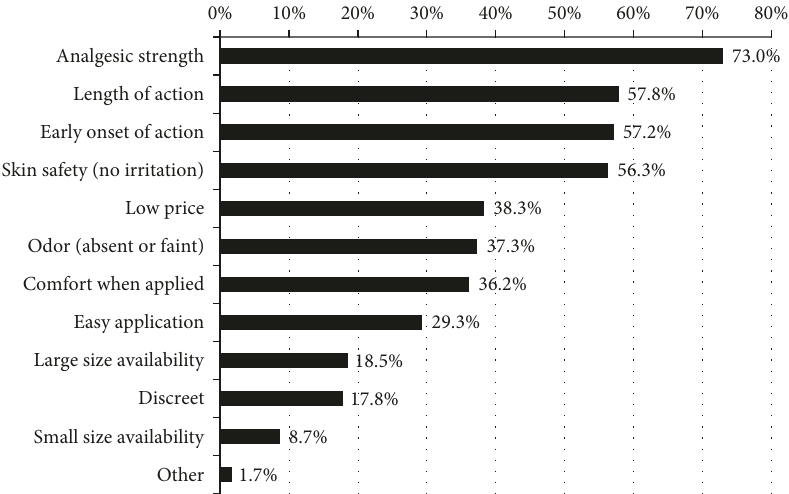
Figure 1: Patient survey: desired characteristics of plasters (multiple responses allowed). Patients prioritized analgesic efficacy and other items related to efficacy. Safety and cost were also